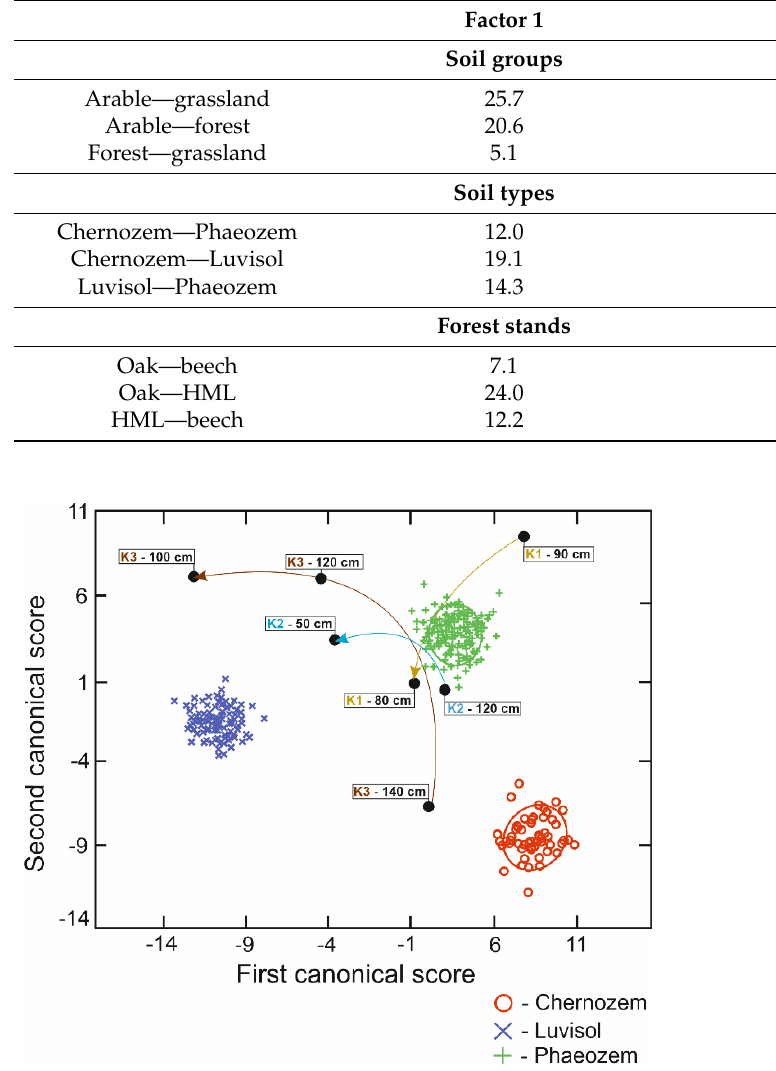
Figure 6. Canonical scores of Chernozem, Phaeozem and Luvisol classes.